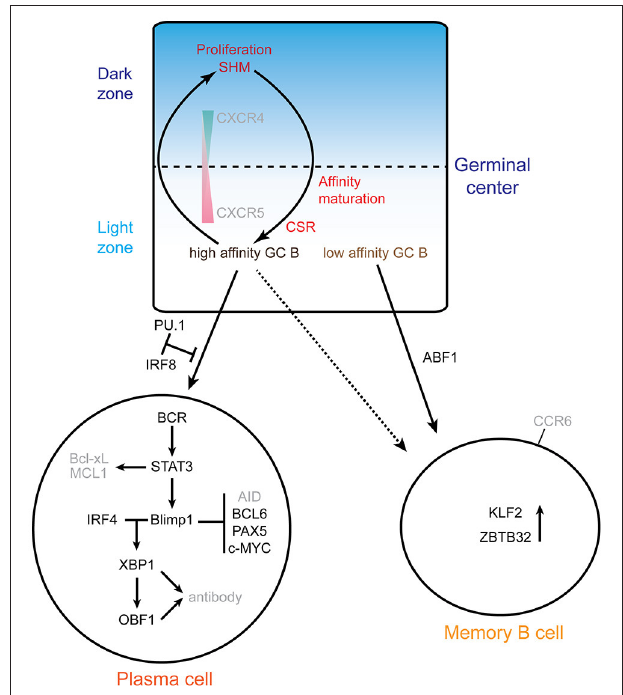
FIGURE 2 | Exit from the GC: memory vs. plasma cells. The top scheme highlights the cycling of B cells between the dark zone and the light zone. The gradients of the chemokine receptors CXCR4 and 5 are indicated, as well as the processes involved. GC B cells proliferate and undergo somatic hypermutation (SHM) in the GC DZ, and then migrate to the light zone where the affinity of mutated BCRs is selected. B cells with high affinity BCR are selected to reenter the DZ for several rounds of SHM or can differentiate into plasma cells. Memory B cells are mainly originated from B cells with low affinity BCR. The alternative fates of B cells exiting the GC are depicted at the bottom: plasma cells or memory B cells. The main networks that have been identified are indicated. In the plasma cell differentiation pathway, PU.1 and IRF8 negatively regulate plasma cell differentiation. IRF4 and BLIMP1 form the central axis in establishing plasma cells. BLIMP1 further suppresses the expression of Aicda , Bcl6 , Pax5 and c-Myc genes and finally terminates the GC program. BLIMP1 positively regulates Xbp1 expression, makes the cells ready for antibody production and secretion. ABF1 promotes memory B